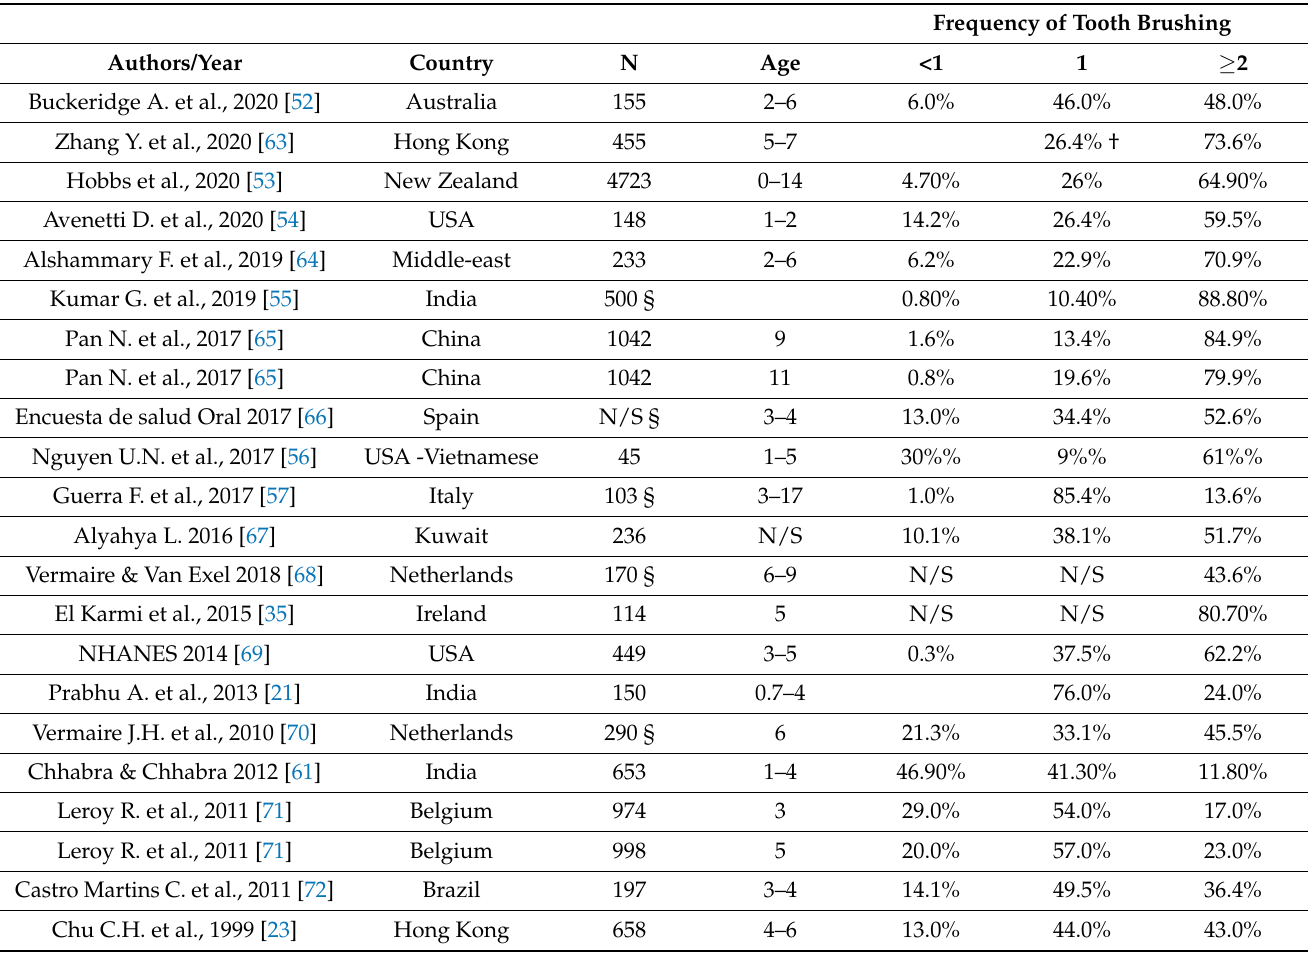
Table 2. The daily frequency of toothbrushing reported in recent